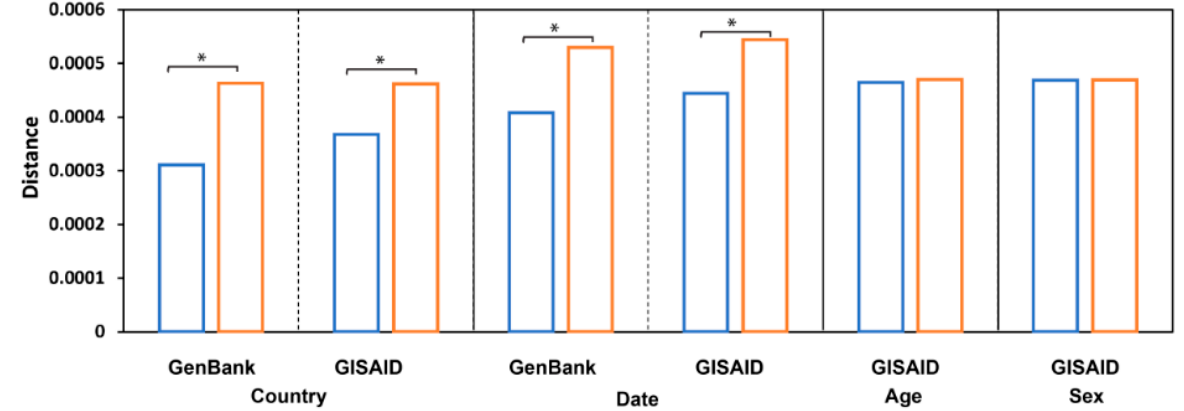
Figure 5. Pairwise sequence distances. The average distance between sequences from the same groups (blue bars, from sequence comparison within the same country/date/age/sex) and from different groups (orange bars, from sequence comparison of different country/date/age/sex) is depicted at the y ‐ axis. Sequences are grouped by countries, sample collection time, patient age, and patient sex (the x ‐ axis label). The groups with significant differences, p < 0.05, were labeled with stars (*).